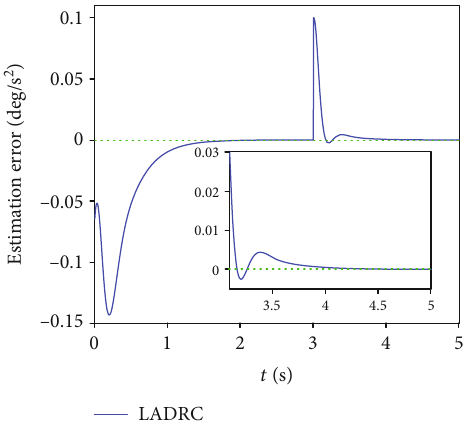
Figure 17: Estimation error of f with LADRC.